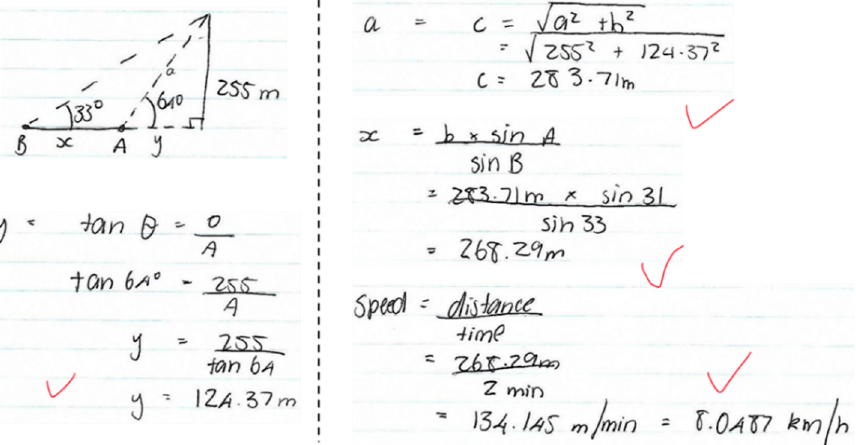
Figure 4. Recaptured student’s work correctly solved the first problem by mixed